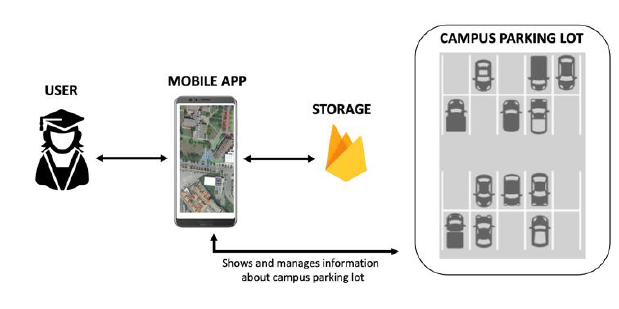
Figure 1. General Overview with the main components: User, Mobile App, Storage and Parking Lot.